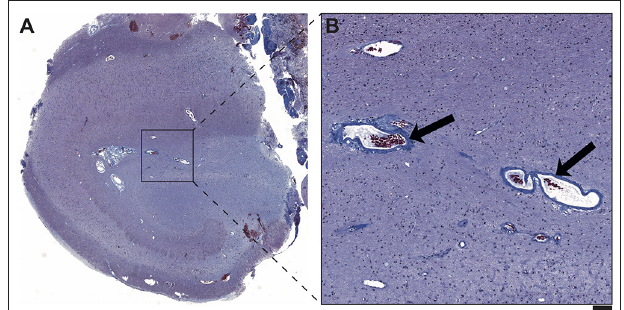
FIGURE 3 | (A) On the Masson Trichrom staining, no signs of microvessel disease or fibrinoid necrosis in the hippocampal formation of Patient #4 are detected. (B) The figure reveals representative vessels with regular wall structure (arrows) in the hippocampal area with maximal neuronal damage. No significant vascular wall inflammatory infiltrates are visible. Overall, there also were no neuropathological correlates of vasculitis in this hippocampal formation. Scale bar corresponds to 500 µ m in A and to 100 µ m in